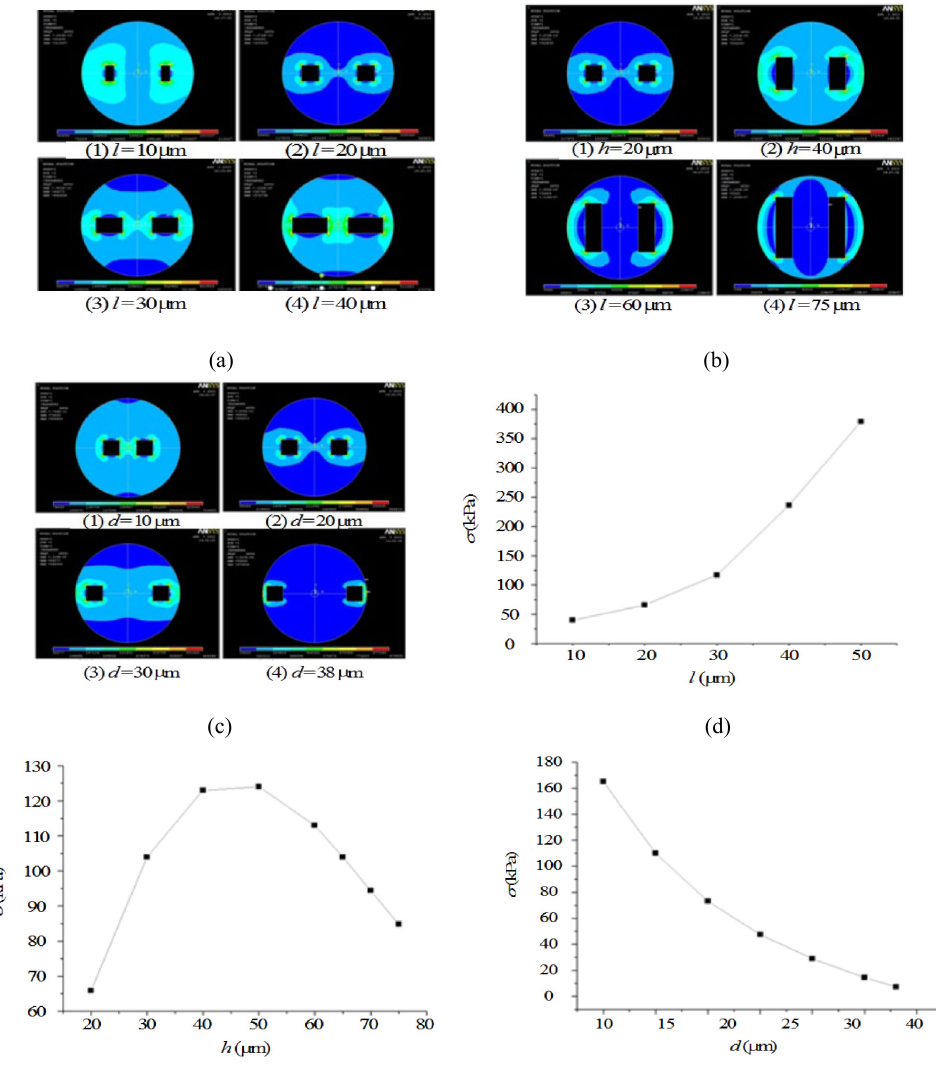
Fig. 5 Strain field distribution of different rectangular-core side-hole fibers: (a) varying length l of rectangular holes with fixed h = 20 µ m and d = 31.25 µ m, (b) varying height h of rectangular holes with fixed l = 20 µ m and d = 31.25 µ m, (c) varying distance d with fixed l = 20 µ m and h = 20 µ m, strain difference versus (d) length l , (e) height h of rectangular holes, and (f) distance d between the centers of the core and holes.